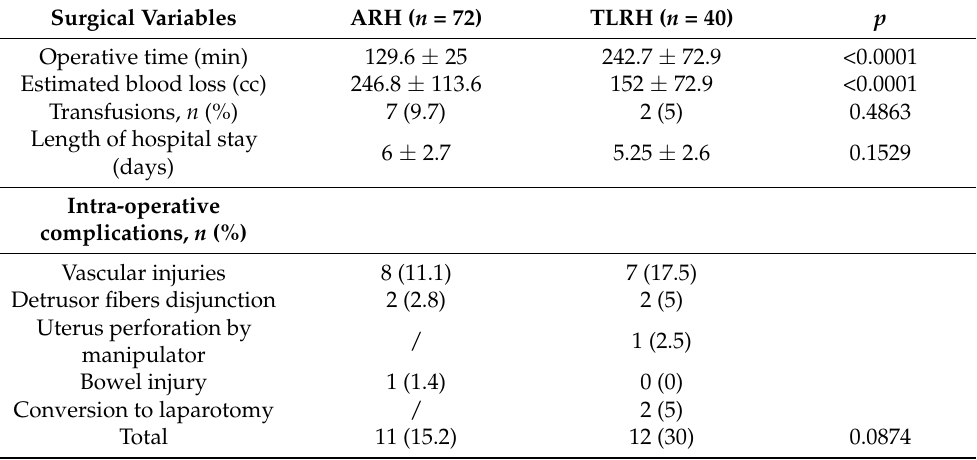
Table 4. Surgical, intra-operative and post-operative complications in women who underwent abdominal radical hysterectomy (ARH) and total laparoscopic radical hysterectomy (TLRH) for cervical